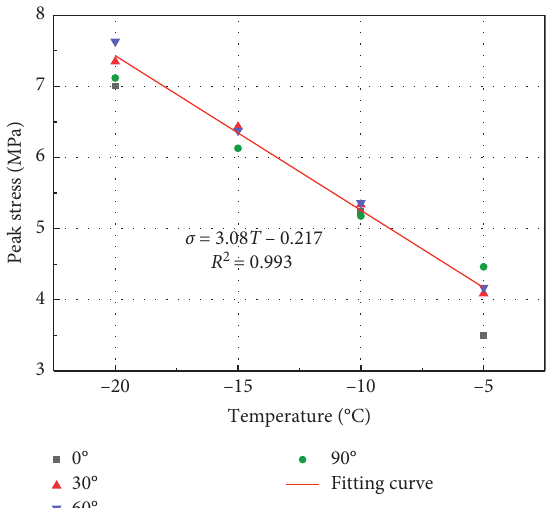
Figure 5: Peak stress change of frozen fractured sandstone with loading angle and freezing